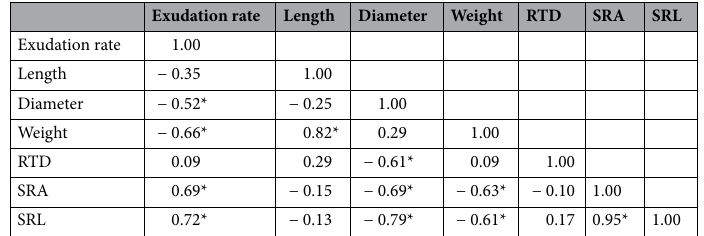
Table 3. Correlation between different root parameters and exudation rate (mg C g −1 day -1 ). *Correlation significant with p < 0.05.